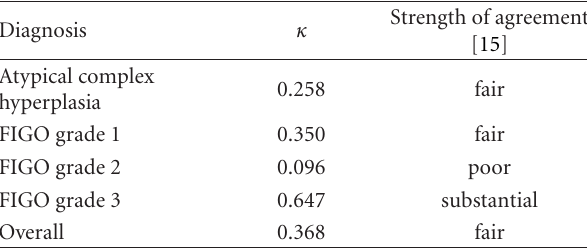
Table 1: Level of agreement on tumor grade using 3-tiered